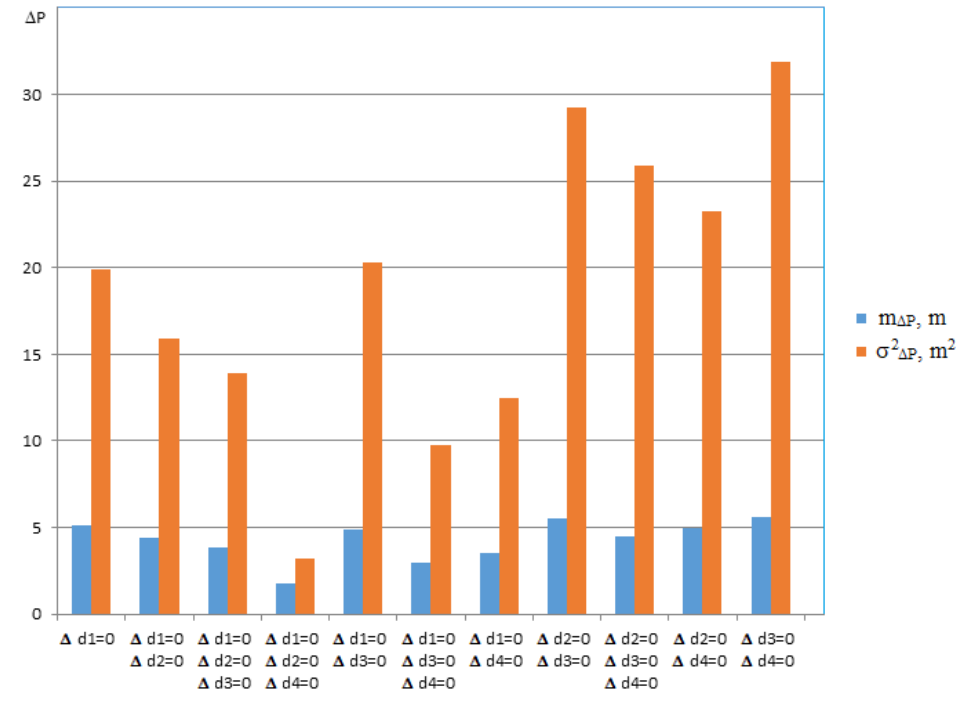
Figure 9. Accuracy of ACS positioning for straight flight and various distance measurement: errors Δ d 1 – 4 .